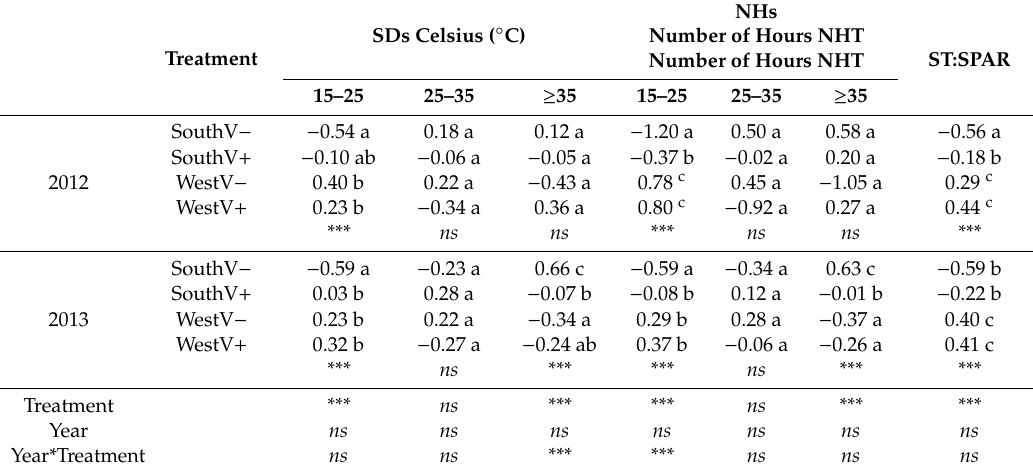
Table 3. Normalized Sum of the Degrees Celsius (SDs), number of hours (NHs) related to the temperature ranges (15– 25; 25– 35; ≥ 35) and ST:SPAR; ST = summation of the maximum daily temperatures; SPAR = summation of the daily integrals of